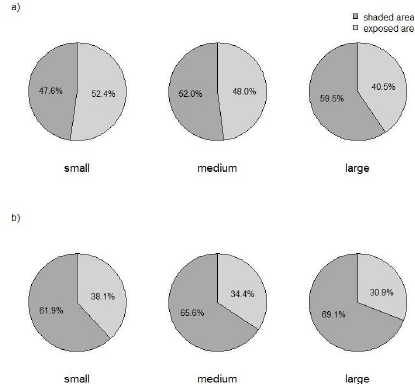
Figure 2. Mean proportion of shaded area observed in 243 nurseries in Bavaria, southern Germany, stratified by size of the nursery: ( a ) shade over entire outdoor area; ( b ) shade over play area. Small <50 children, medium 50–99 children, large ≥100 children.